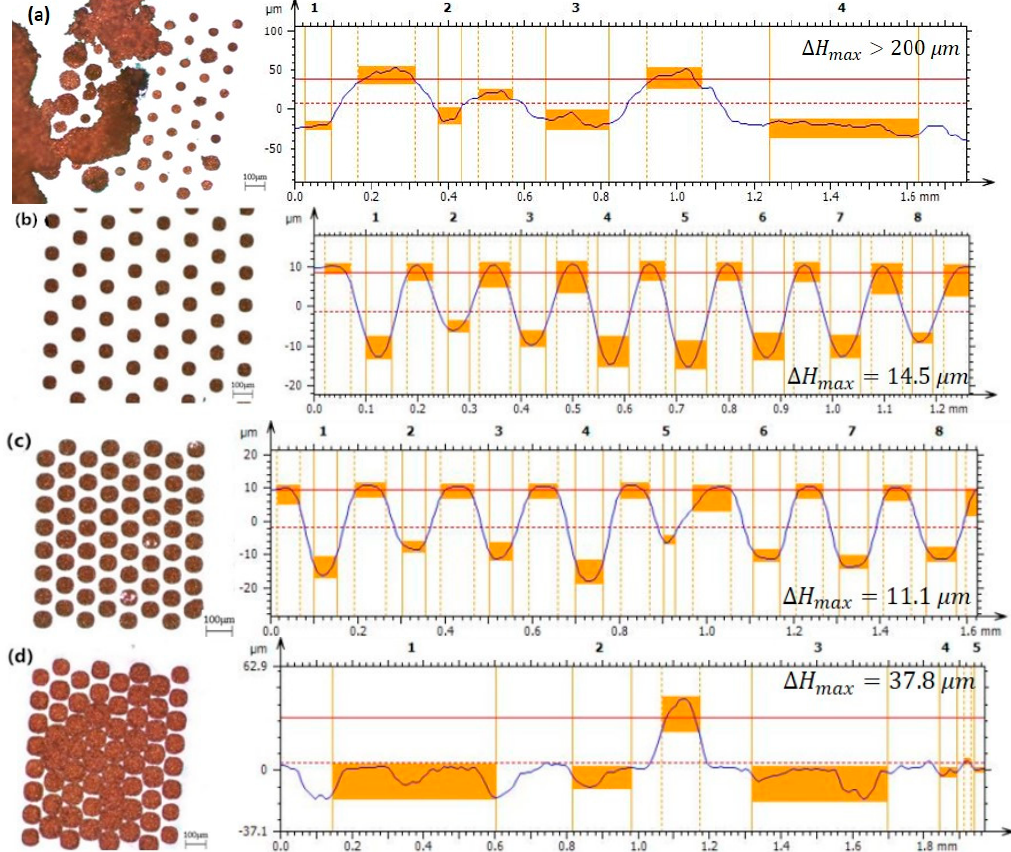
Figure 6. Top views and profile height diagram taken from the section with the greatest height difference under different additive concentrations obtained with an optical microscope and confocal displacement detector: ( a ) A: 0.25 mL/L, B: 0.25 mL/L; ( b ) A: 0.5 mL/L, B: 0.5 mL/L; ( c ) A: 1 mL/L, B: 1 mL/L; and ( d ) A: 1.5 mL/L, B: 1.5 mL/L.